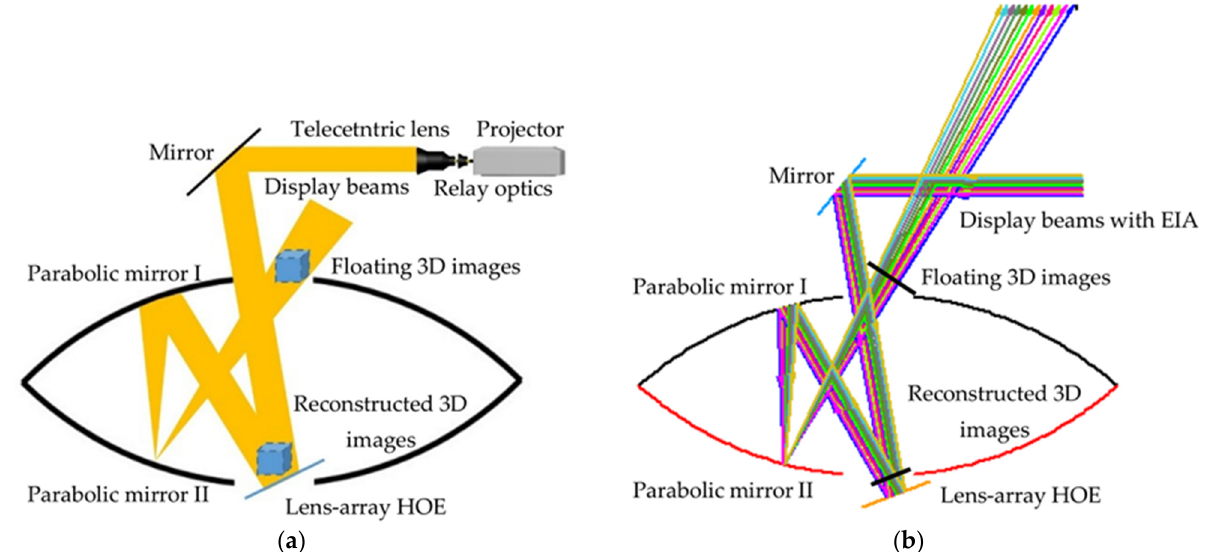
Figure 6. ( a ) The imaging principle of the aerial projection 3D display; ( b ) the simulation results of ray tracing for aerial projection 3D display.